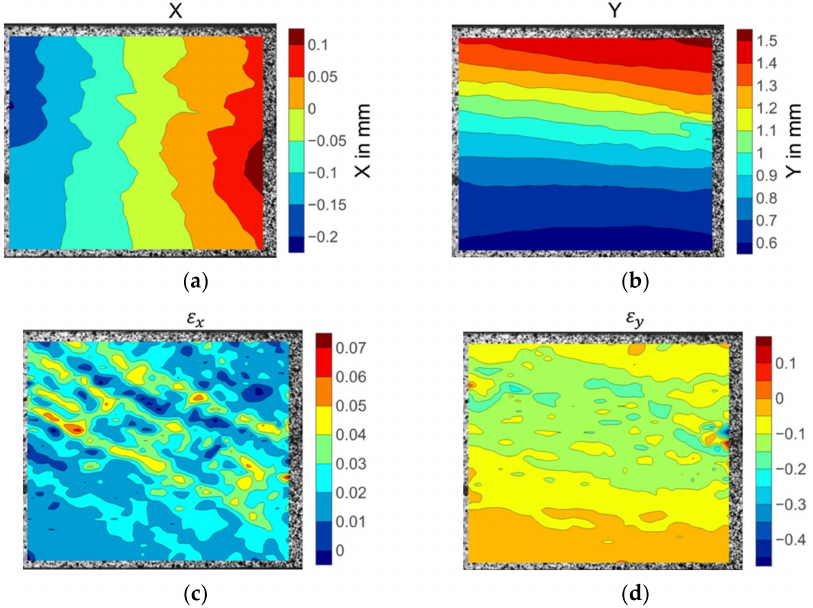
Figure 12. The displacement and strain field contour plots of the 60 ◦ off-axis specimen: ( a ) Displace- ment in the X direction; ( b ) displacement in the Y direction; ( c ) strain in the X direction; ( d ) strain in the Y